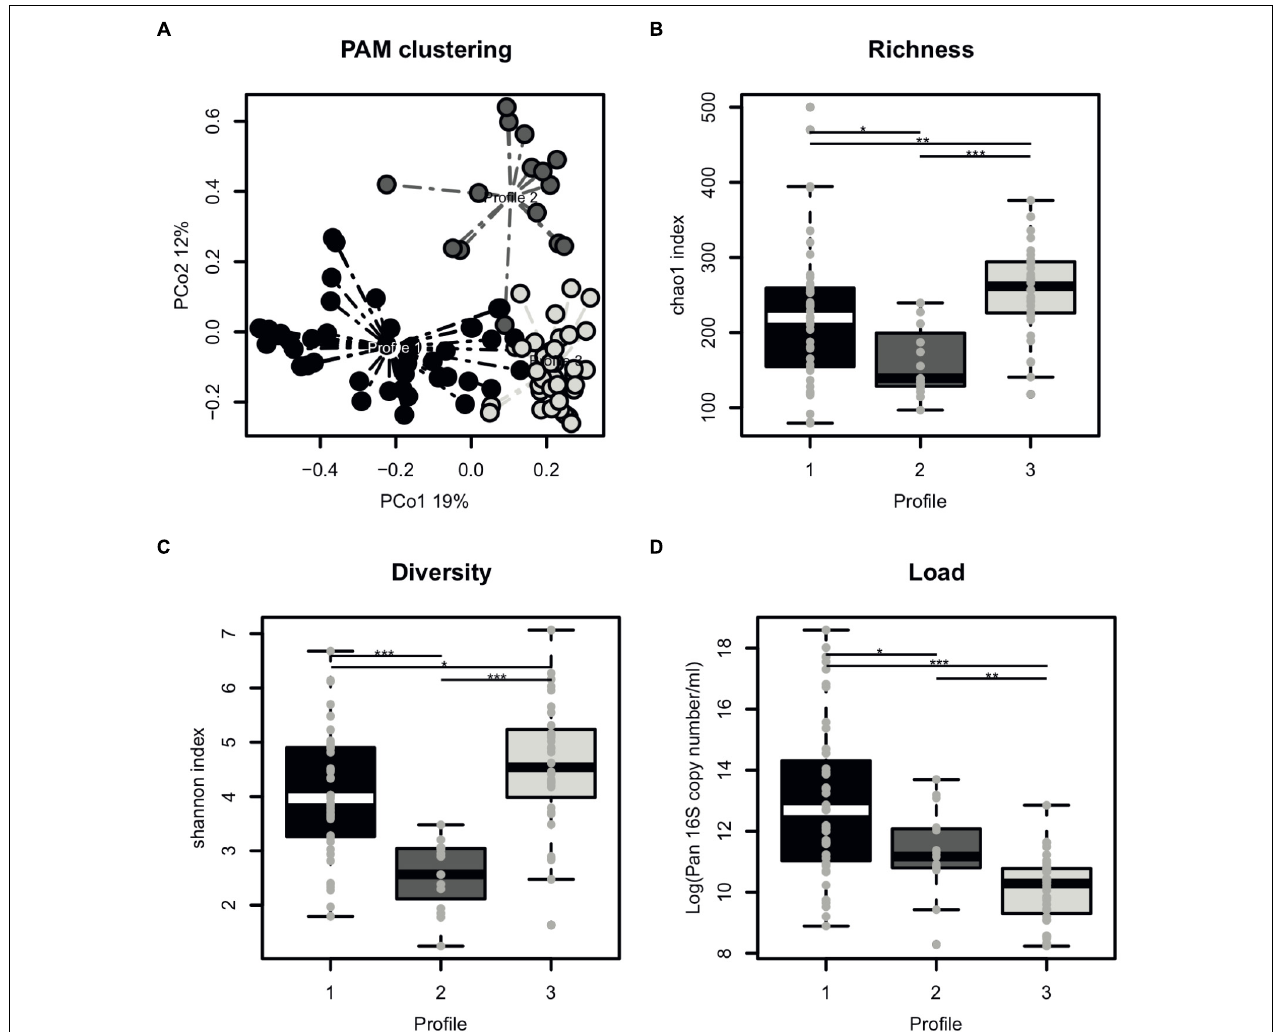
FIGURE 2 | Characterization of semen microbiota profiles. (A) Principal Coordinate Analysis (PCoA) score plot on the Bray-Curtis distance at genus taxonomic level with each dot representing an individual patient explaining 19% (x axis) and 12% (y axis) of variance, respectively. Colors indicate microbiota profile, as defined by unbiased Partitioning Around Medoid clustering (PAM) clustering with dashed line representing connection to the cluster centroid. (B) Boxplot comparing the richness of microbiota profiles, as measured by chao1 index. (C) Boxplot comparing the diversity of microbiota profiles, as measured by chao1 index. (D) Boxplot comparing the total bacterial load of microbiota profiles, as determined by Pan 16S qPCR. Each dot represents an individual patient with mean boxplot indicating the mean plus or minus SD. Statistics represents the result of post hoc one-tailed Wilcoxon rank sum